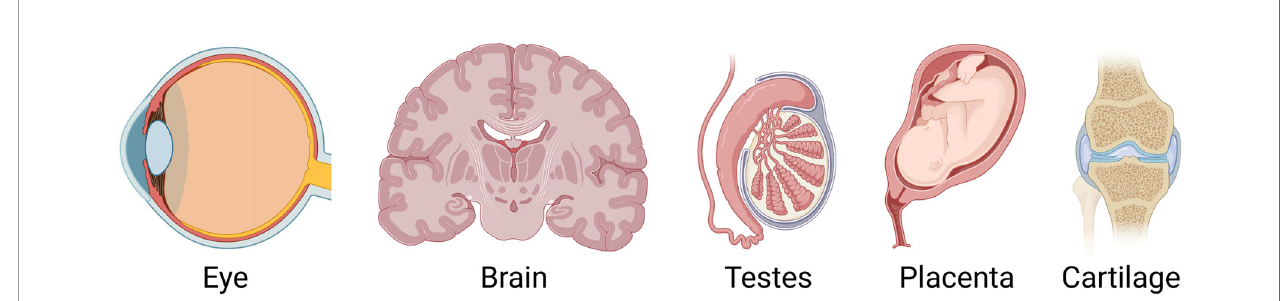
FIGURE 1 | The classical immune privileged sites are the eye, central nervous system, placenta, testes and articular